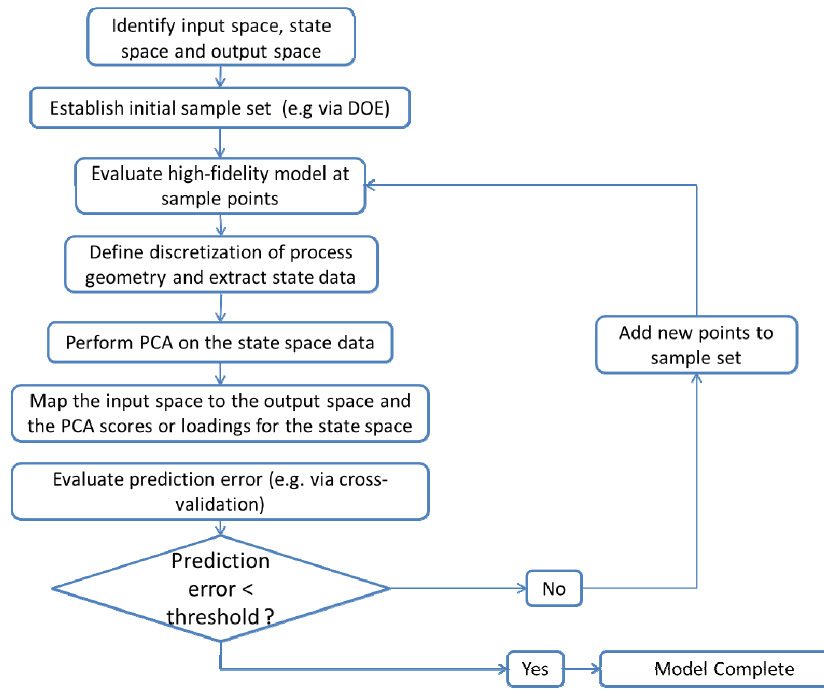
Figure 7. Algorithm for reduced order modeling based on principal component